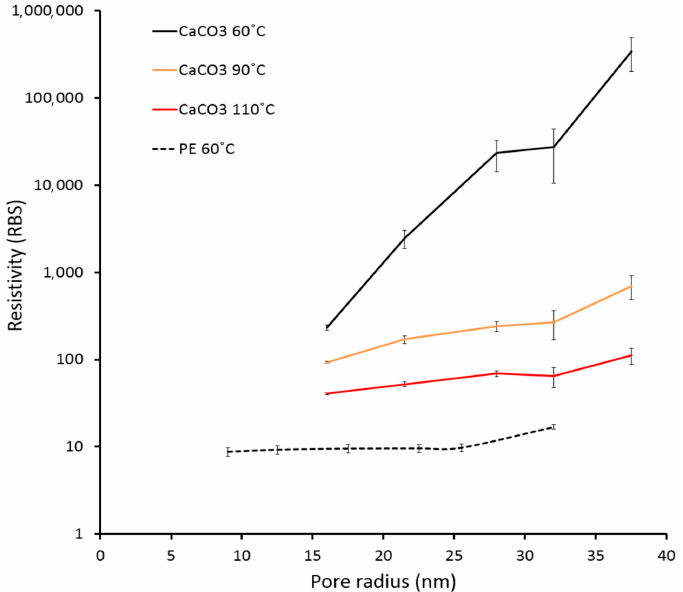
Figure 3. Resistivity of AgNP films as a function of the coating pore radius. The sintering inhibition on active papers (solid curves) is stronger when using larger pore sizes. The error bars correspond to ±1 standard deviation. RBS = resistivity of bulk silver.